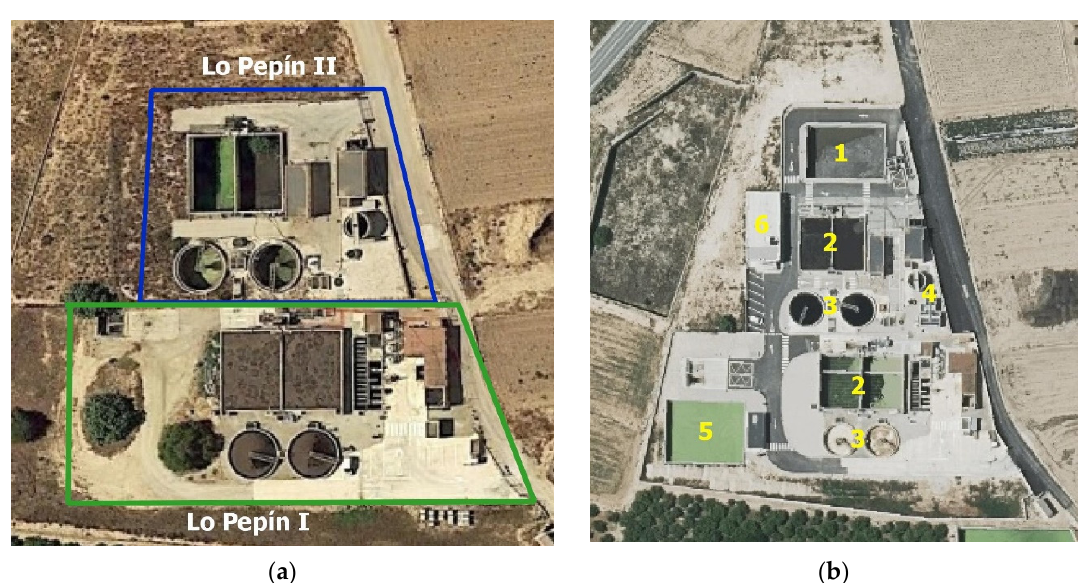
Figure 3. ( a ) Lo Pepín I and II WWTP before adaptation and integration; ( b ) Lo Pepín WWTP after integration. Key: Purification process. (1) Anti-SWWW tank, (2) biological aeration, (3) clarification,